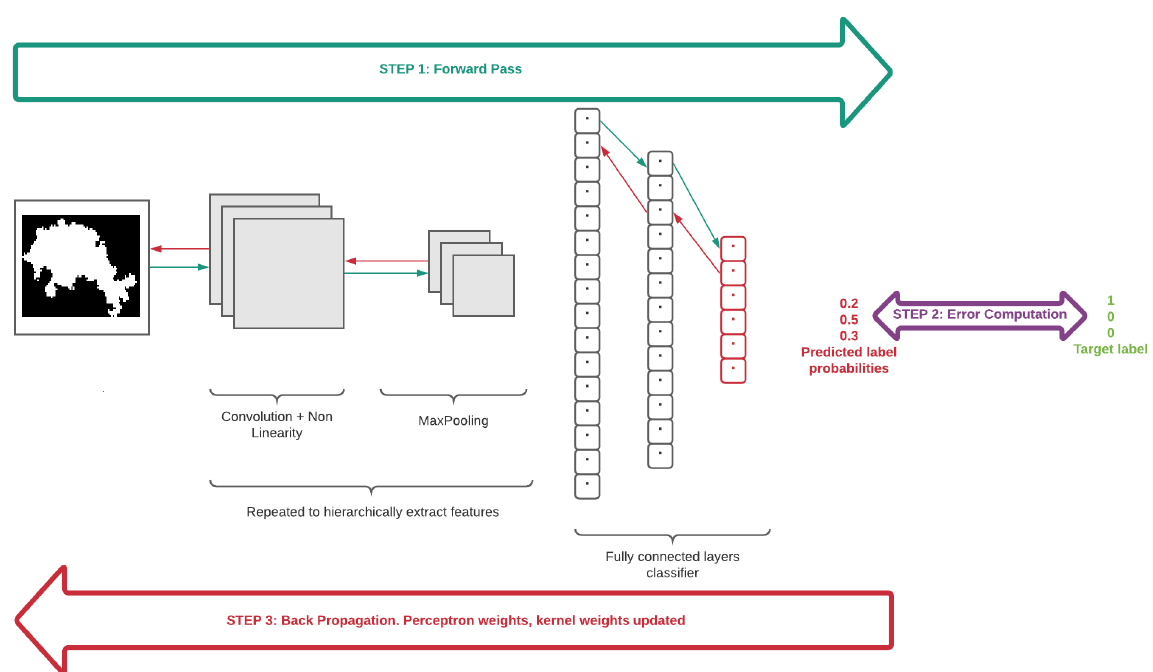
Figure A1. The three steps leading to parameter improvement. (1) Forward pass: the image is passed through the network and an output is obtained. (2) An error is computed between this prediction and the target output. (3) This error is propagated by gradient descent back into the network to update the trainable parameters in the